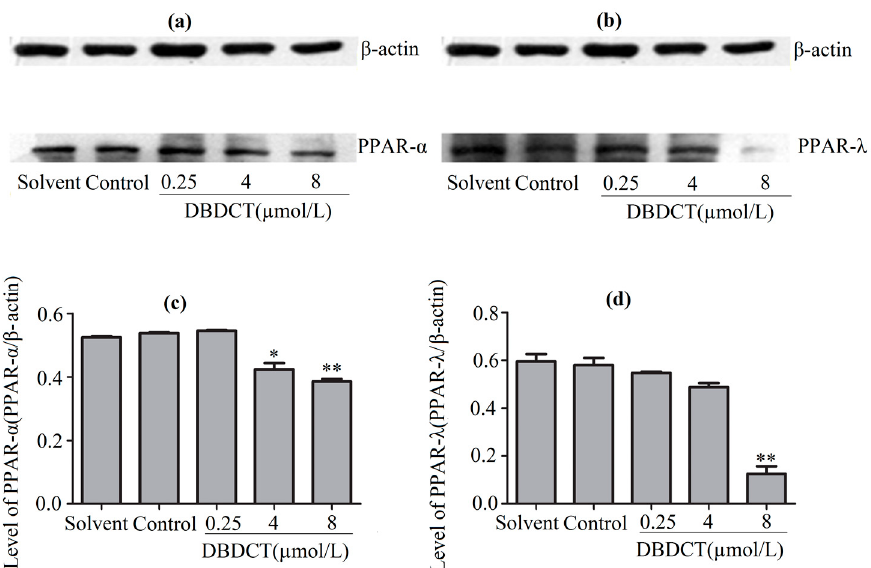
Figure 6. The expression levels of PPAR- α and PPAR- λ proteins in BRL cells with the treatment of DBDCT (0.25, 4 and 8 μ mol/L). ( a , b ) The Western blot results; ( c , d ) Relative protein expression levels of PPAR- α and PPAR- λ in cells. The results are expressed as a ratio of the expression levels of the reference protein β -actin (* p < 0.05; ** p < 0.01; compared with control group).